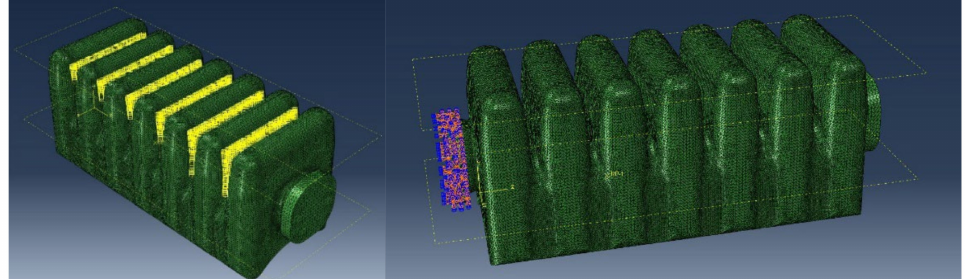
Figure 2. Simulation model and boundary condition of the pneumatic